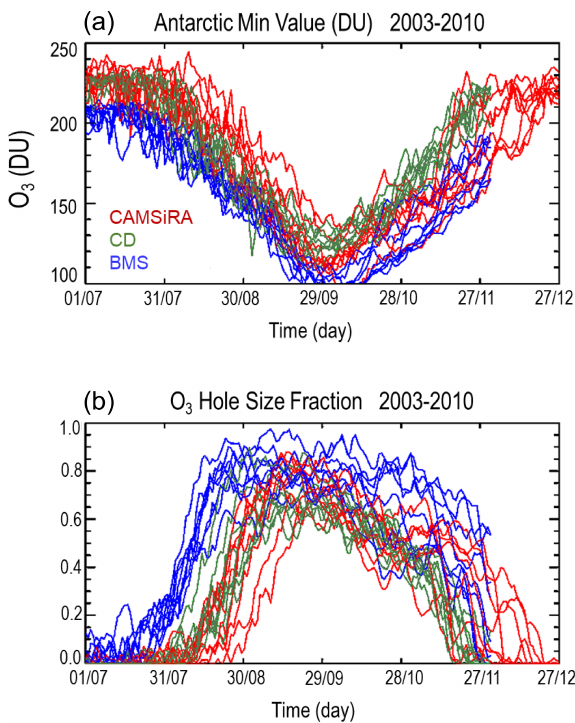
Figure 4. Time series of daily values of the total ozone column (DU) over the Antarctic region (a) and of the ozone hole size frac- tion (b) from July to December, for the years 2003–2010. Model results come from long-range model ensemble experiments with May starting date (see text for details) using the default stratospheric ozone scheme (green lines) and the new stratospheric ozone scheme (blue lines). The values corresponding to the CAMSiRA reanalyses are also shown (red